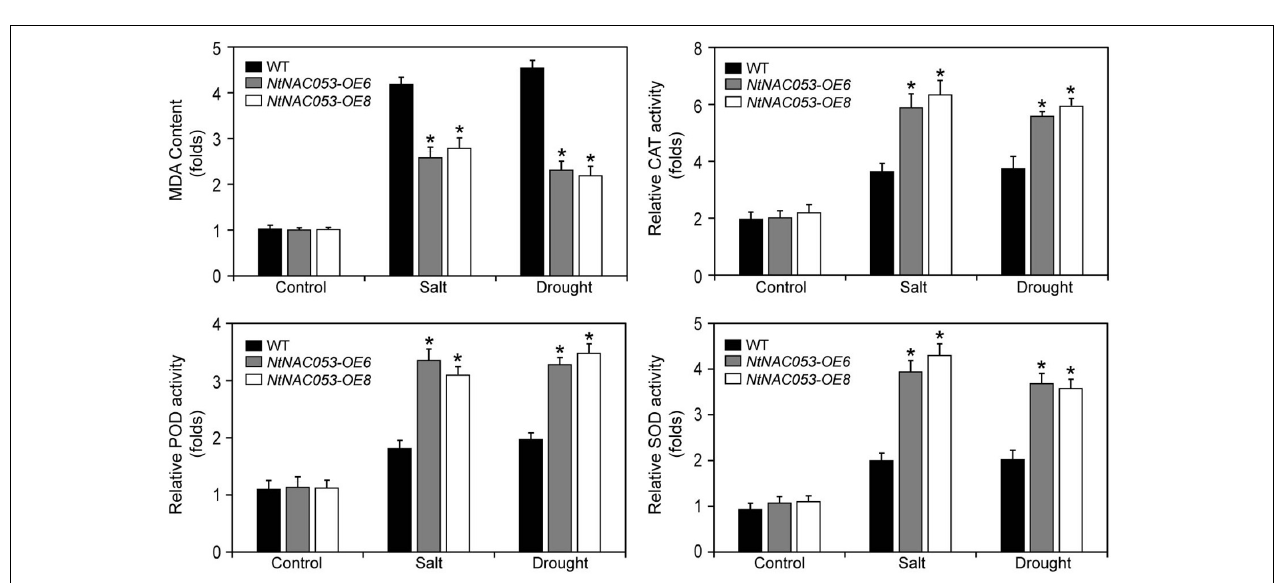
FIGURE 8 | Analysis of the antioxidant enzyme activities and MDA contents in overexpression lines and wild-type tobacco under salt and drought stresses. MDA, malonic dialdehyde; CAT, catalase; POD, peroxidase; SOD; superoxide. WT, wild type. The MDA content and enzyme activity were calculated as folds relative to the level of before treatments. The data were means ± SD from three independent replications. * p < 0.05 ( t -tests).